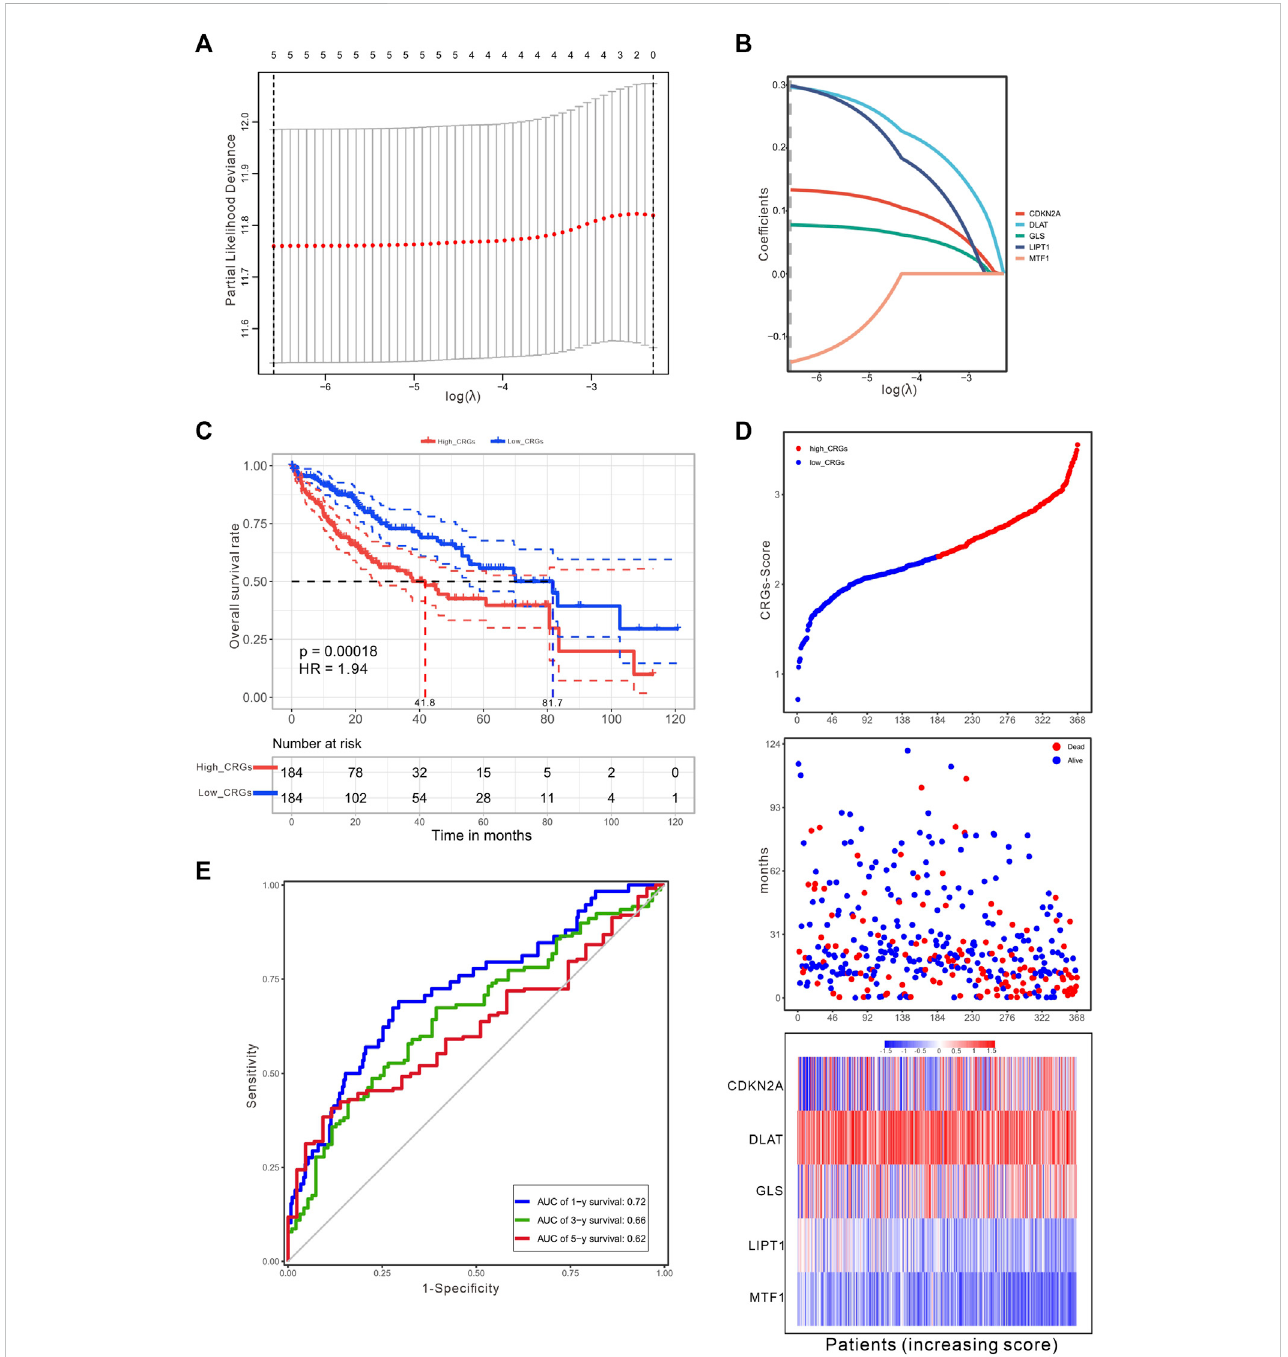
FIGURE 4 Construction of a prognostic CRGs model. (A) The LASSO-COX model screened out prognostic CRGs and carried out 10-fold cross-validation. The λ valuewascon fi rmedas.0014 where theoptimallambda resulted in fi venon-zerocoef fi cients. (B) LASSO coef fi cient pro fi les ofthe fi veCRGs. (C) The survival curvesforthedifferentCRGs-scoresubgroupswiththecut-offvalue2.309among368HCCpatients(Log-ranktest, p =.00018,HR=1.94).ThemeanOSfor the high and low CRGs-score group were 41.8 and 81.7 months, respectively. (D) The distribution of CRGs-score, survival status, and the expression of fi ve prognostic CRGs in HCC. (E) The time-dependent receiver operating characteristic (ROC) analysis of CRGs-score. The AUC values were .72, .66, .62 at 1 year, 3 years, and 5 years,